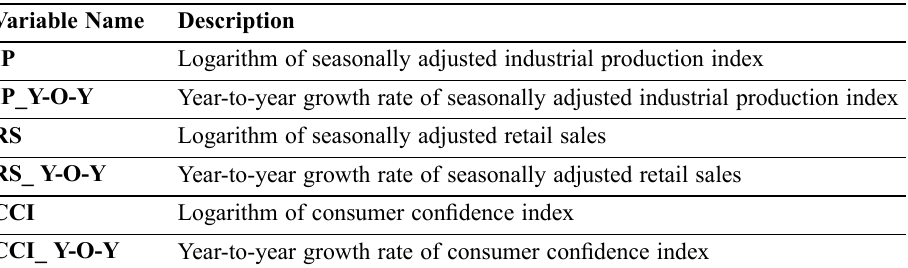
Table 1. The variables and their